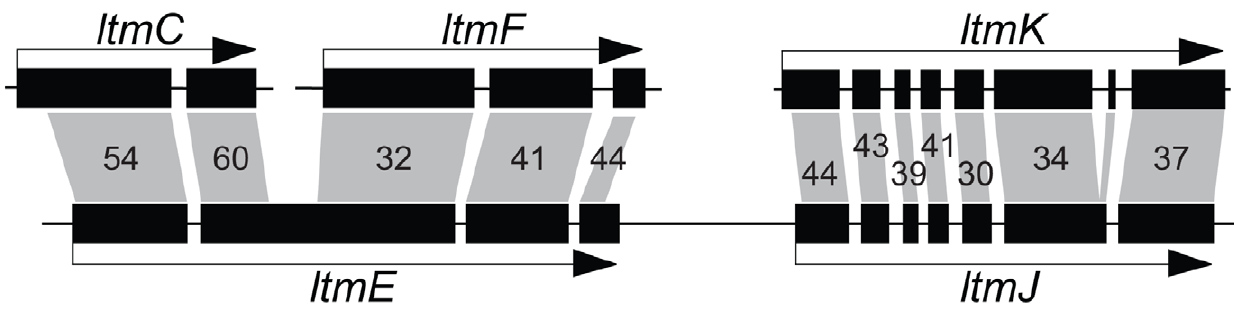
Figure 8. Relationships of ltmE and ltmJ with other LTM genes. Filled boxes indicate coding sequences of exons. Gray polygons indicate closest BLASTp matches to inferred polypeptide sequences for each exon, and are labeled with percent amino-acid identities.